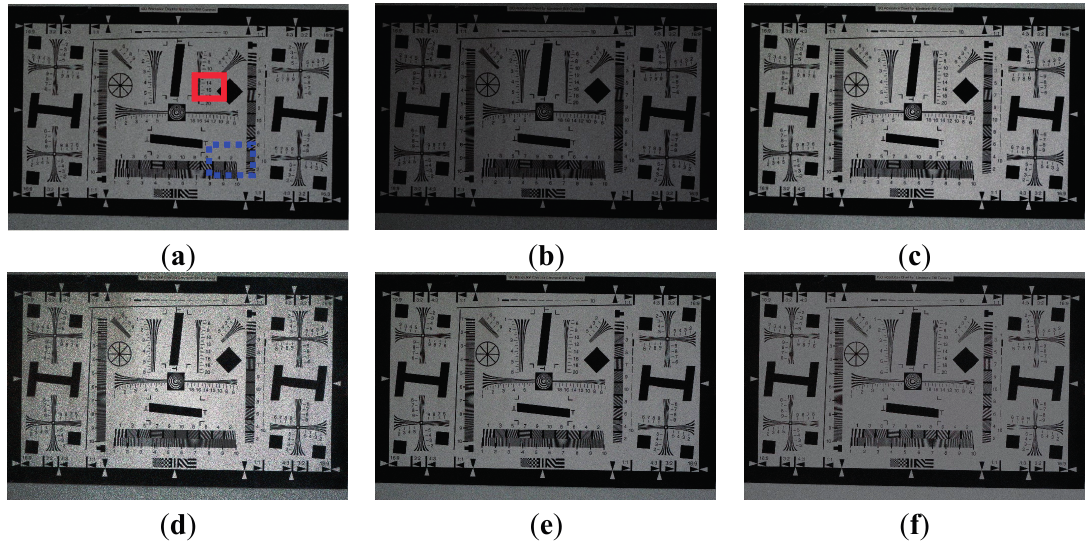
Figure 6. Enhancement results using the ISO 12233 resolution chart image: ( a ) The reference image with ISO 3200 (EV = 0); ( b ) one-step lower exposure image using ISO 1600 (EV = − 1); ( c ) enhanced image of (b) using the ordinary two-pixel digital pixel binning; ( d ) enhanced image of (b) using Kim’s algorithm; ( e ) enhanced image of (b) using Jiang’s algorithm; and ( f ) enhanced image of (b) using the adaptive four-pixel digital pixel